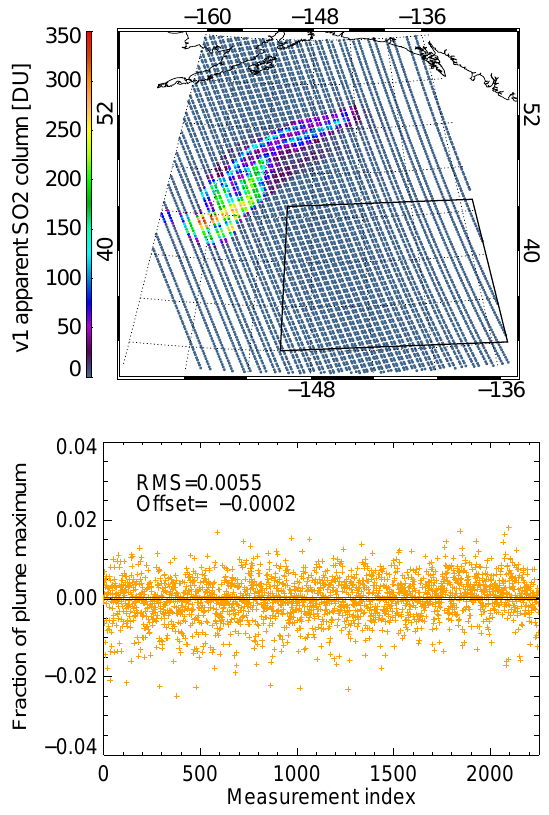
Fig. 4. The plume of SO 2 for the morning overpass on 10 Au- gust 2008 using the ν 1 band filter for Method (1) as described in the text using the modelling approach to compute S tot (cid:15) . Fractional varia- tion in the background normalised according to the maximum value within the plume (326DU) shown in the bottom panel for IFOV’s inside box. Reported 1 σ sensitivity ( σ c ) for this filter of 0.0022 (=0.734DU). Observed RMS of background=0.0055. Expected climatological value shown as red line. Mean value of background value shown as black